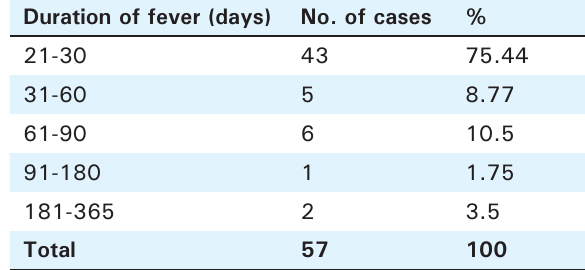
Table 2. Distribution of duration of fever in patients with FUO